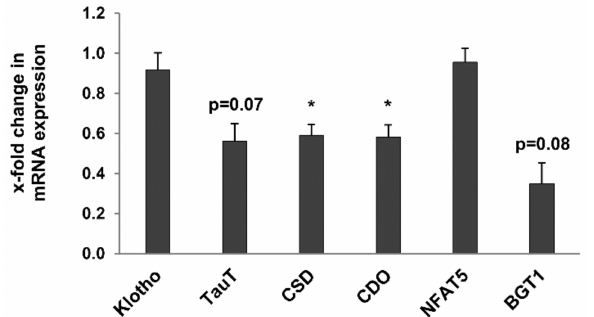
Figure 9. Expression of age-related renal metabolic markers in kidneys of 3- and 24-month-old rats by RT-qPCR expression of the anti-ageing kidney-secreted factor Klotho and of NFAT5, a transcription factor involved in the response to hypertonic and hypoxic stress in the kidney was not significantly altered in old rats. Expression of cysteine sulfinate decarboxylase (CSD) and cysteine dioxygenase (CDO), two enzymes involved in taurine biosynthesis, was significantly downregulated in 24-month- old rats. Similarly, expression of the taurine and betaine transporters, TauT and BGT1 respectively, was also reduced in old rats, albeit not significantly. Data was normalized with respect to the corresponding values determined in 3-month-old rats. p -values ≤ 0.05 are indicated by one